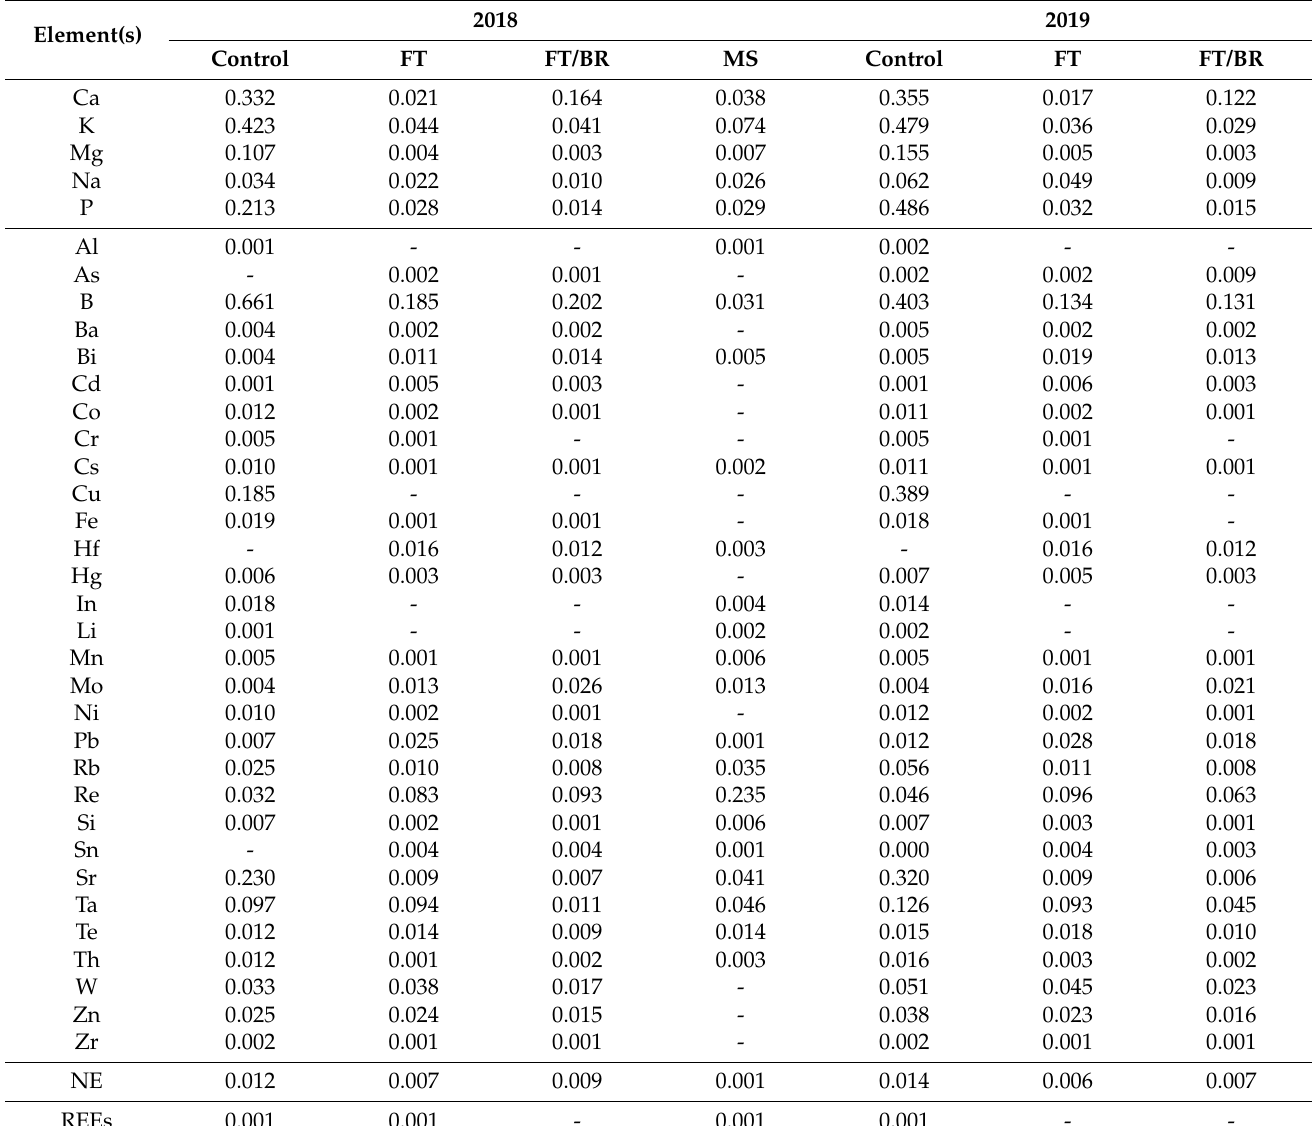
Table 4. Metal extraction ratio (MER) values (%) for major and trace elements determined in Paulownia plants growing under particular experimental systems ("-“ means MER value below